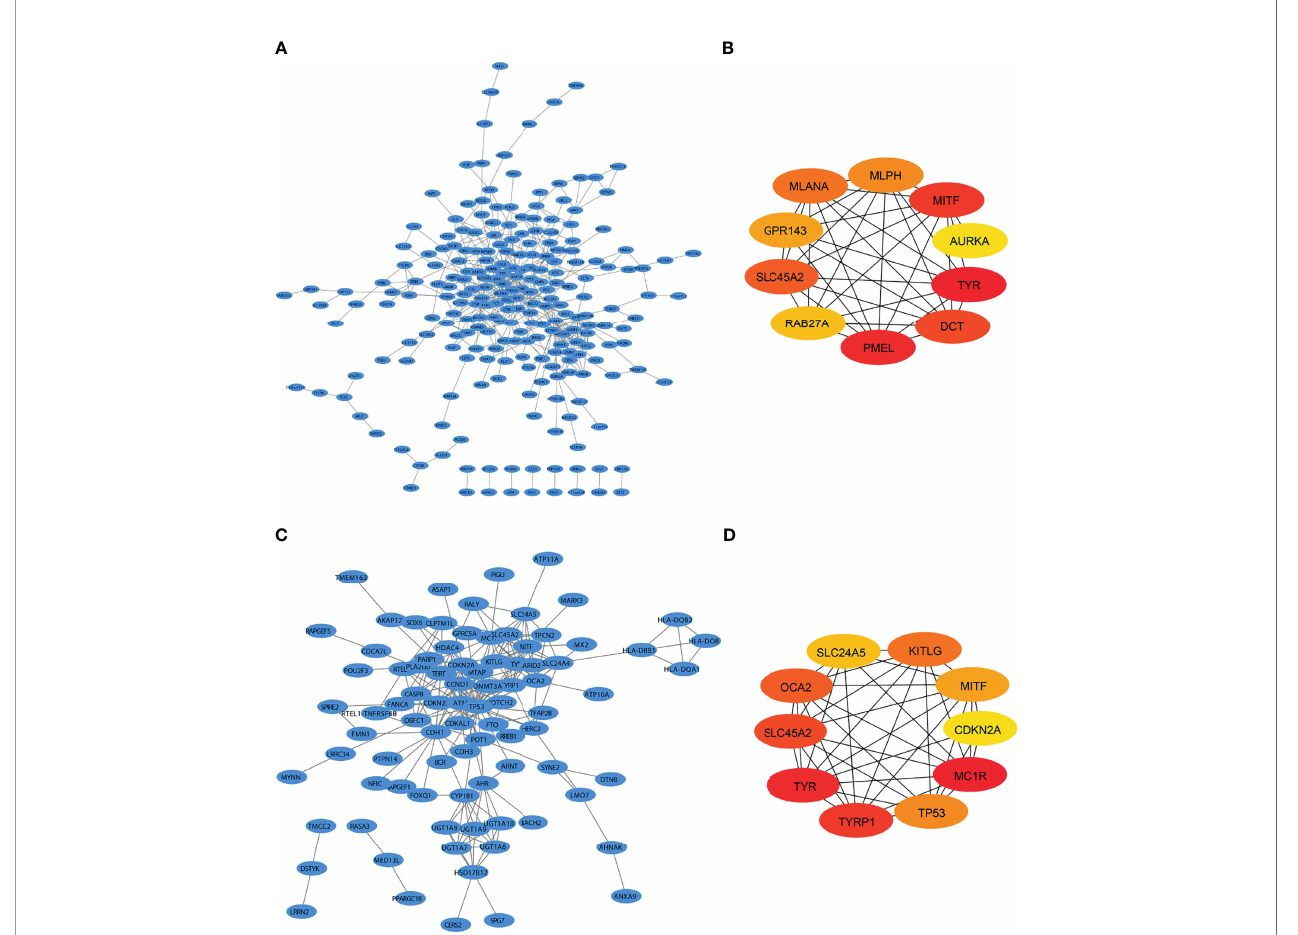
FIGURE 2 | Identi fi cation of SKCM-related genes by both WGCNA and GWAS. (A) Protein interaction (PPI) network of the genes that are most positively related to SKCM identi fi ed by WGCNA. (B) PPI network of the top 10 genes identi fi ed by WGCNA. (C) PPI of SKCM-related protein coding genes identi fi ed by genome-wide association study (GWAS). (D) The protein interactions of the top 10 genes identi fi ed by